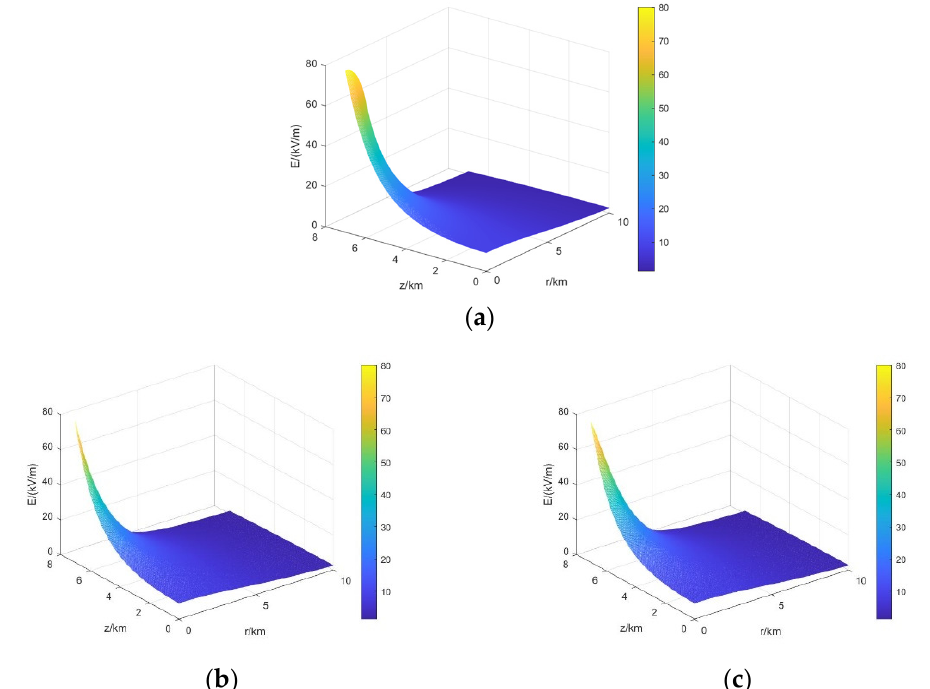
Figure 1. ( a ) Electric field distribution calculated with exact solution. ( b ) Electric field distribution calculated with the first-order approximate solution. ( c ) Electric field distribution calculated with the second-order approximate solution.